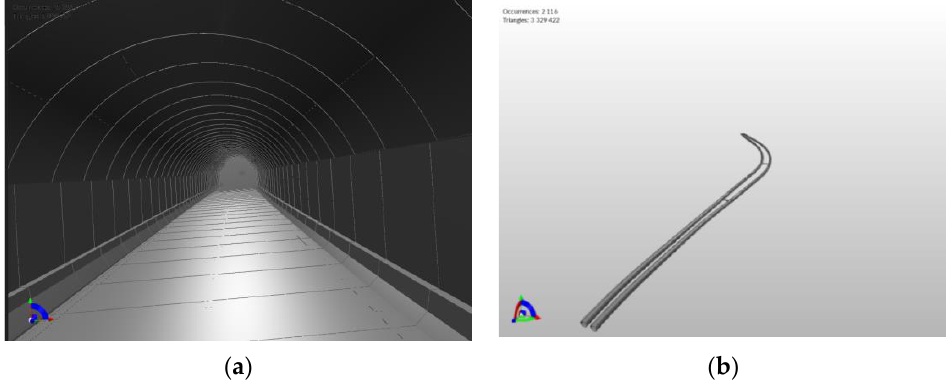
Figure 4. Example of the lightweight processing method and results of the tunnel model. ( a ) Orig- inal BIM model; ( b ) BIM model after lightweight treatment.